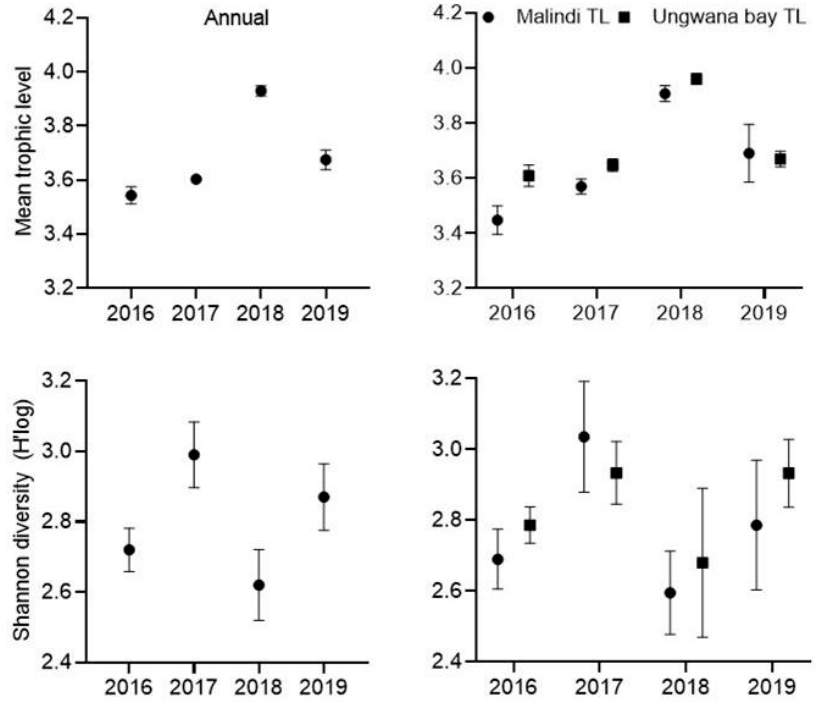
Figure 4. Annual mean trophic level and mean species diversity: general and on each bay. Error bars: SE.